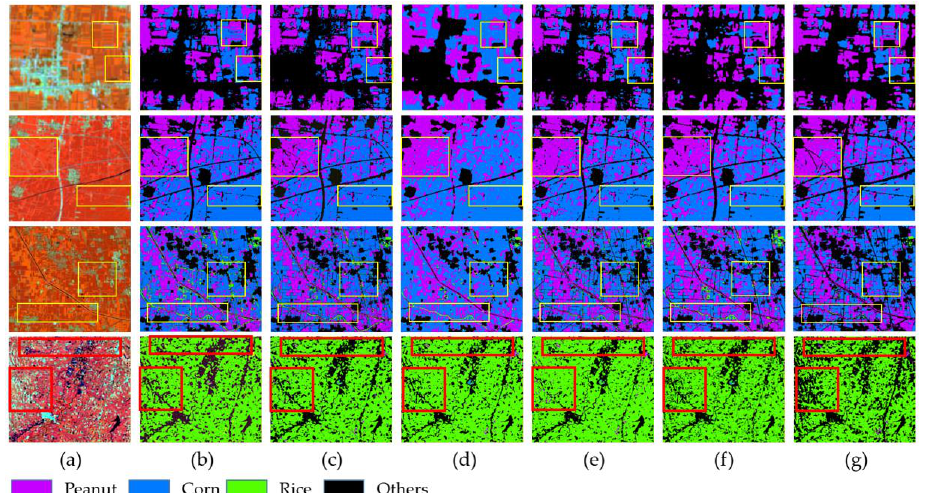
Figure 10. Some examples of the results on the dataset. From left to right: ( a ) Band 8, Band 11, Band 4 false color synthesis of Sentinel-2 image; ( b ) RF; ( c ) XGBoost; ( d ) CNN; ( e ) CNN-RF; ( f ) S 3 ANet; ( g )